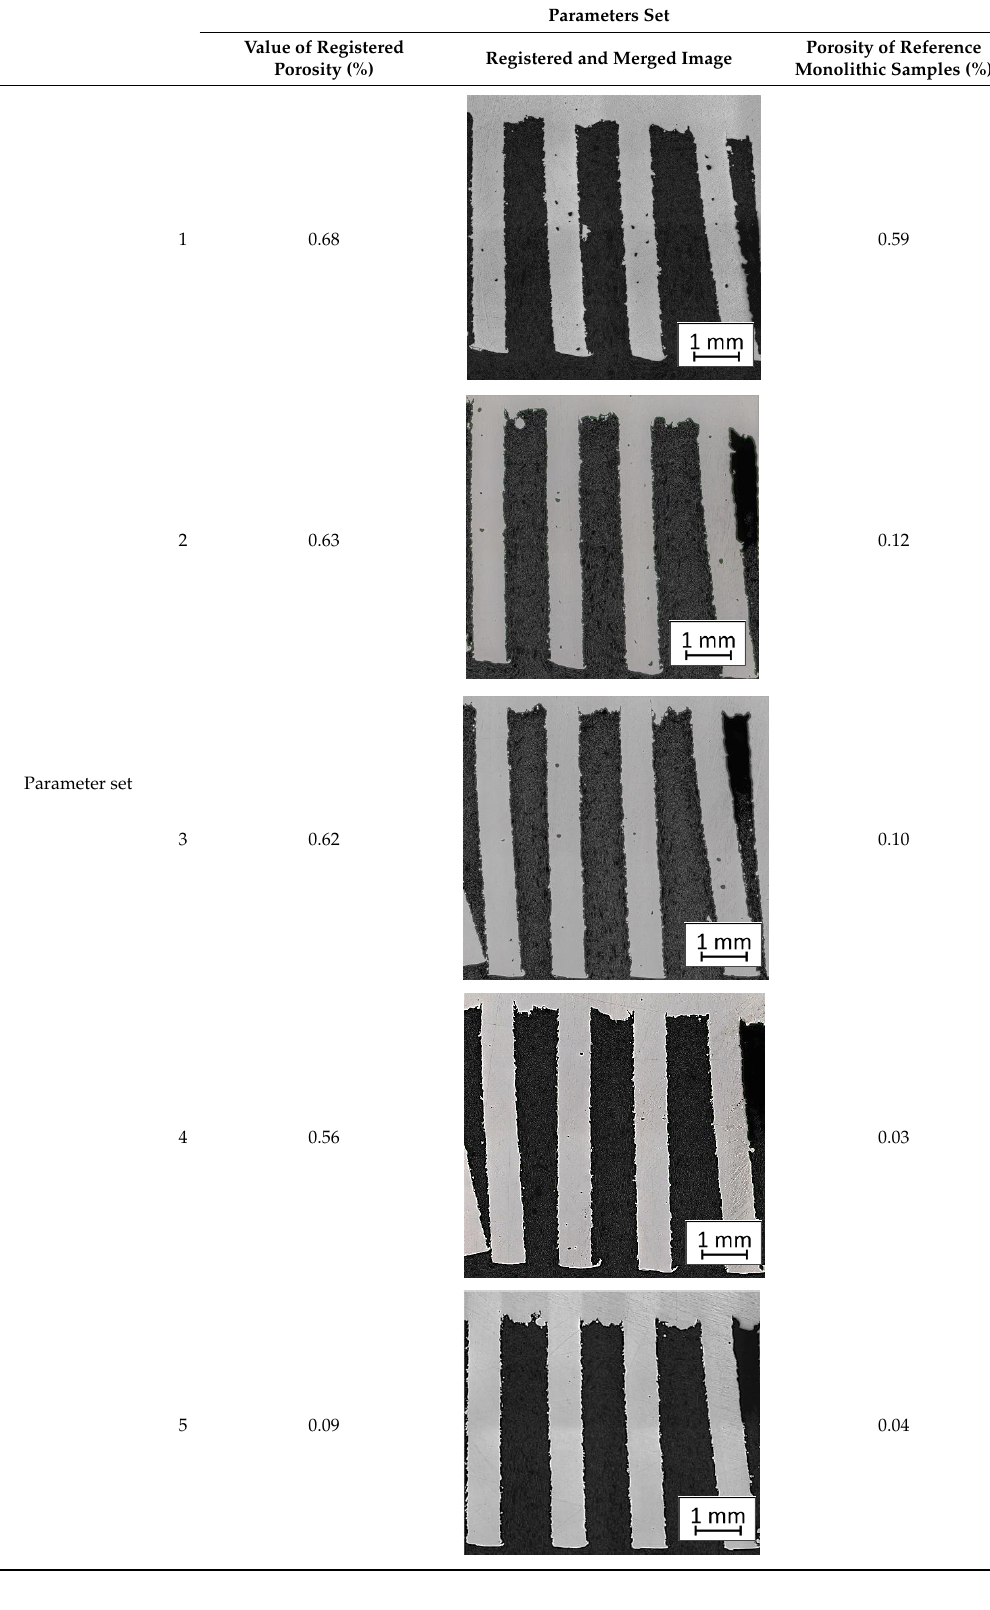
Table 4. Porosity in samples 1–5.